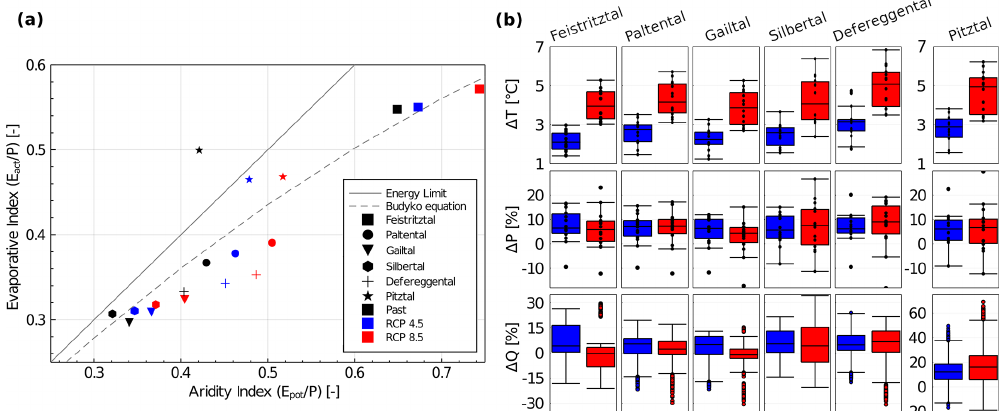
Figure 7. (a) The position of the study catchments in the Budyko framework (Budyko, 1948), based on the 30-year means of all climate simulations in the past and under two emission scenarios at the end of the 21st century. E act is actual evaporation defined as 1 − Q lute changes between past and future in mean annual temperature, as well as relative changes in mean annual precipitation of the 14 climate simulations (black dots representing the individual climate simulations) and in annual runoff of all simulations for RCP4.5 (blue) and RCP8.5 (red). Note the different scale for the runoff of the Pitztal